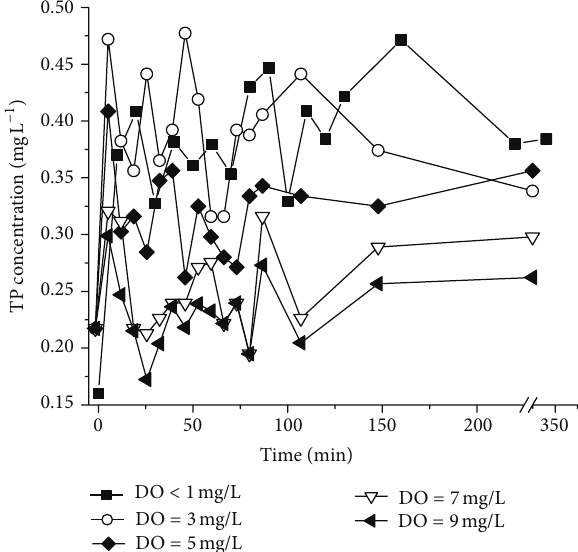
Figure 5: Concentration changes of TP in the DO effect experi-